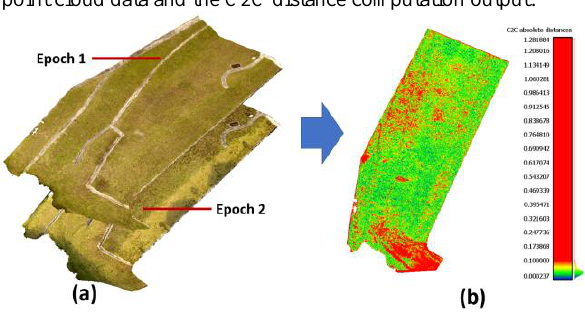
Figure 22. Analysis using UAV-Photogrammetric data – (a) the UAV-photogrammetric point clouds data and (b) the C2C distance computation